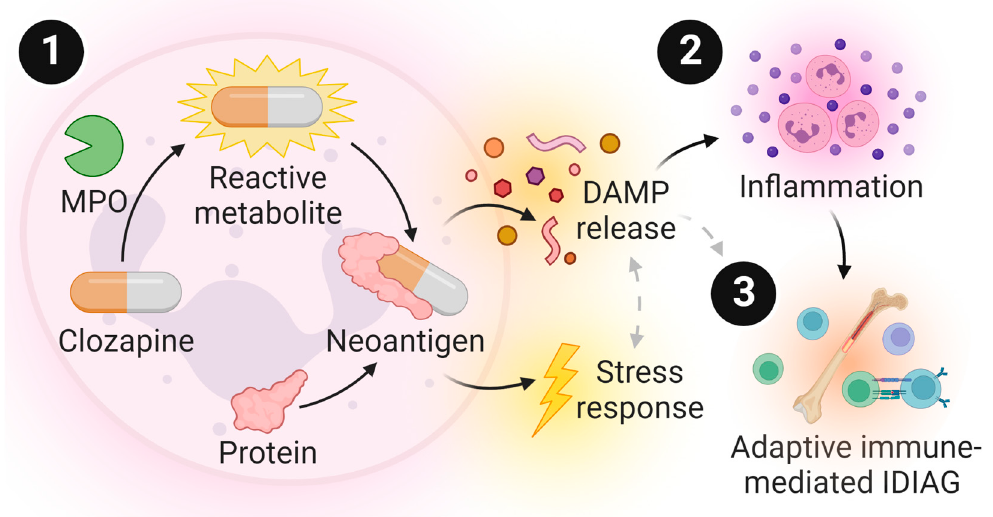
Figure 8. An updated model linking clozapine bioactivation and clozapine-induced inflammation in idiosyncratic drug-induced agranulocytosis (IDIAG). (1) Clozapine is oxidized by myeloperoxidase (MPO)-expressing cells to a reactive nitrenium ion that covalently modifies endogenous proteins, generating neoantigens. Depending on the essentiality and the role of the proteins modified, this causes cellular dysfunction, the release of damage-associated molecular patterns (DAMPs; including S100 and drug-modified proteins), along with other proinflammatory mediators, and activation of a stress response, propagated by cortisol/corticosterone. The stress response may also directly influence the generation of DAMPs and vice versa. (2) These signals initiate the chemotaxis and activation of immune cells such as other neutrophils that can sense DAMPs in several ways, including recognition by pattern recognition receptors, leading to inflammasome activation. Inflammasome signaling propagates a proinflammatory response through the increased release of proinflammatory cytokines (e.g., IL-1 β , CXCL1) and acute phase proteins (e.g., α 1AGP, CRP), as well as mobilization of peripheral immune cells. (3) The presentation of clozapine neoantigens in the context of specific HLA haplotypes on antigen-presenting cells are detected by T cells expressing cognate T cell receptors. In the presence of appropriate co-stimulatory signals, an adaptive immune response is initiated that, if unresolved through tolerance, leads to the targeted destruction of granulocyte precursors and the onset of IDIAG. The inhibition of myeloperoxidase with PF-1355 significantly attenuates clozapine-induced inflammation, ultimately reducing the chance of adaptive immune activation and progression to